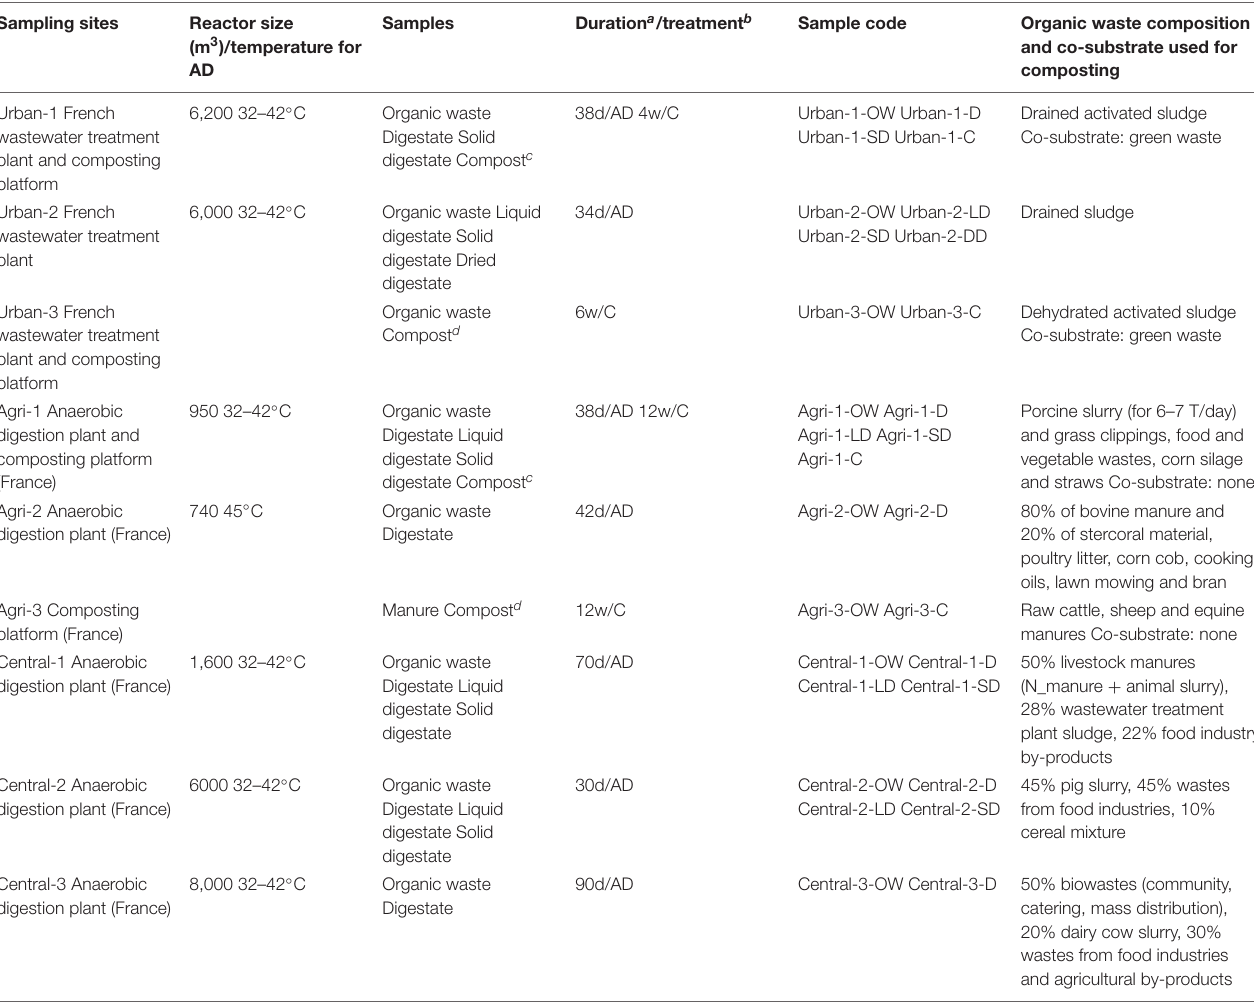
TABLE 1 | Organic waste treatment plants and sample features. Sampling